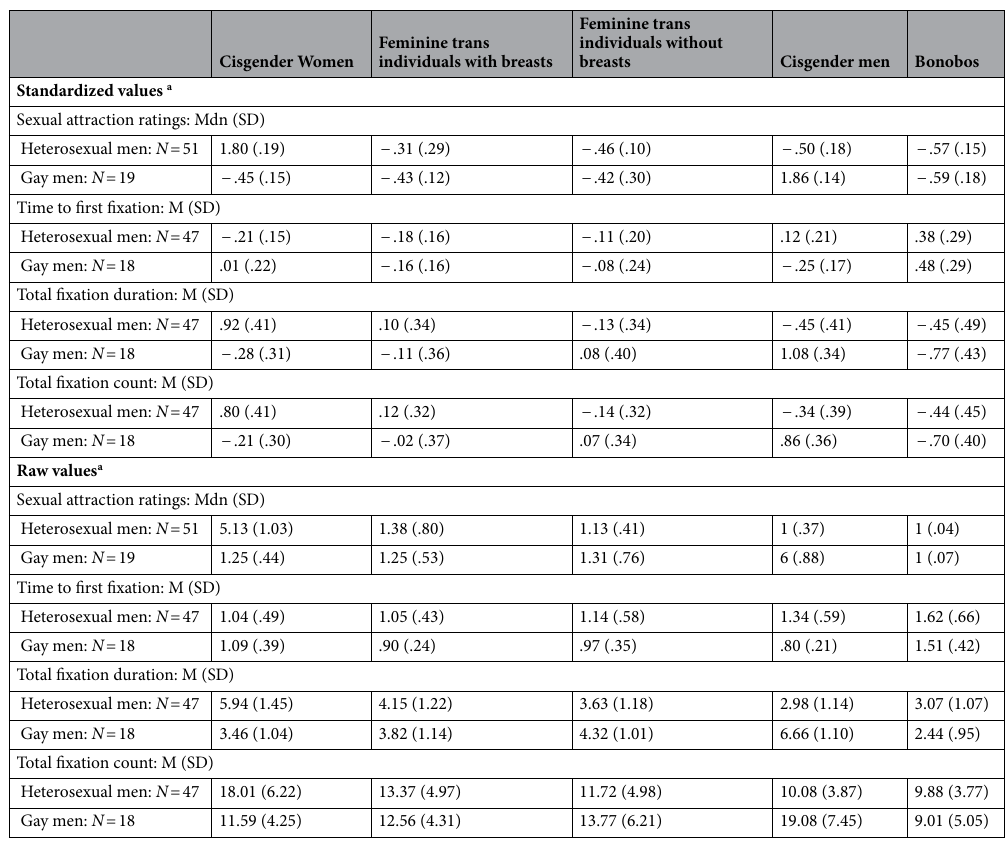
Table 2. Descriptive statistics for self-reported sexual attraction, time to first fixation, total fixation duration, and total fixation count. a Outlying time to first fixation, total fixation duration, and total fixation count values have been